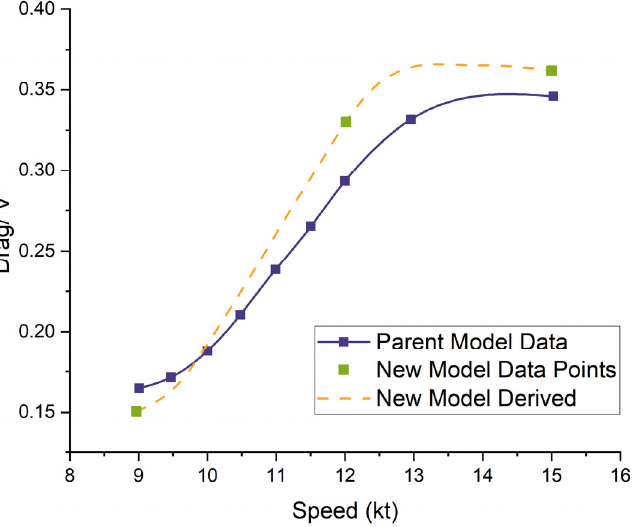
Figure 5. The “ Model with different design parameters but the same topology ” can be estimated with fewer data points (data from [22]).